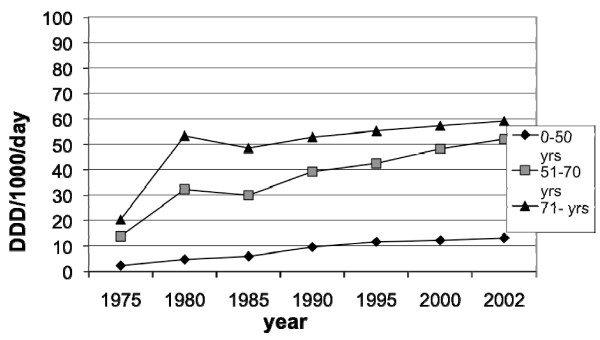
Sales of prescribed NSAID and ASA between 1975–2002 in Sweden among males.